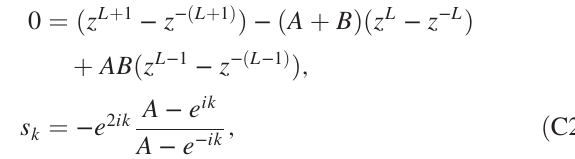
ffiffiffiffiffiffiffiffiffiffiffiffiffiffiffiffiffiffiffiffi p 2 = ð L þ 1 Þ